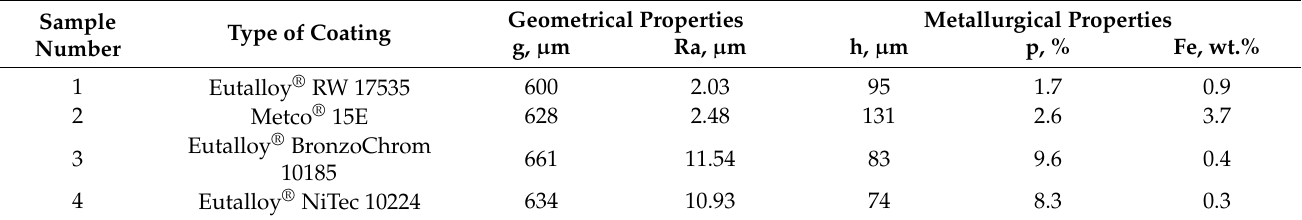
Figure 3. View of the microstructure of the cross-section of coatings sprayed with self-fluxing powder made of Ni-Cr-B-Si alloy (Eutalloy ® RW 17535) and powder made of Ni-B-Si non-fluxing alloy (Eutalloy ® BronzoChrom 10185) and base material of low-alloy boiler steel of the 16Mo3 grade: ( a ) microstructure of the Ni-Cr-B-Si alloy shell, ( b ) microstructure of the Ni-B-Si alloy shell, ( c ) image of porosity of the inner shell of Ni-Cr-B-Si alloy, ( d ) image of porosity of the inner shell made of Ni-B-Si alloy, ( e ) image of HAZ microstructure and base material under Ni-Cr-B-Si alloy coating, ( f ) image of HAZ microstructure and base material under Ni-B-Si alloy coating. Table 7. Geometric and metallurgical properties of sprayed